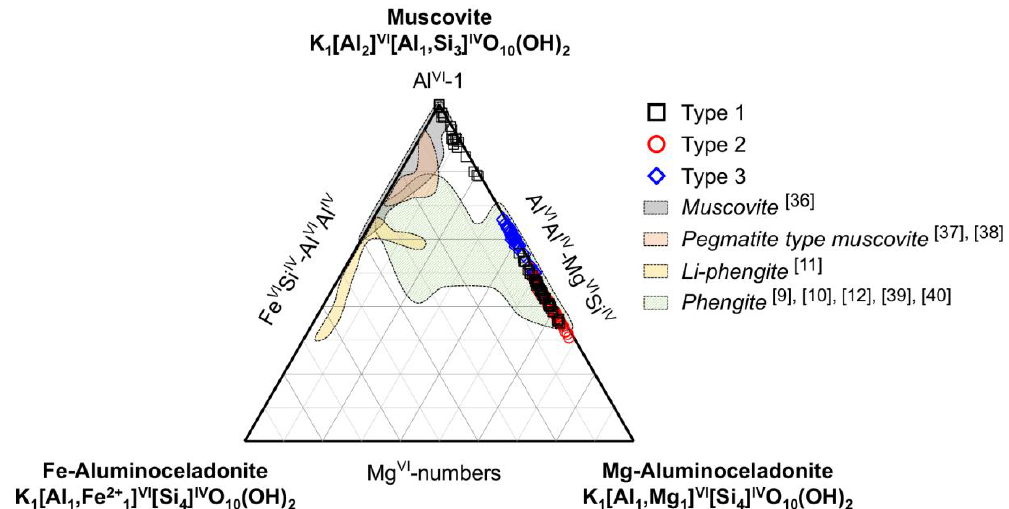
Figure 10. Ternary diagram among muscovite–Fe-aluminoceladonite–Mg-aluminoceladonite. Type 1, 2 and 3 phengites are plotted and compared with some reference muscovites and phengites. Reference